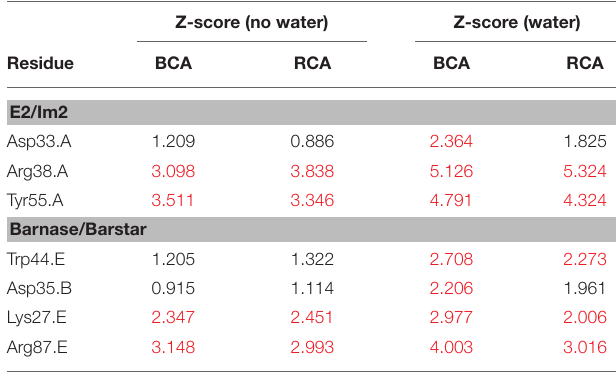
TABLE 2 | List of central residues found in the literature and discussed in the text for the E2/Im2 and the barnase/barstar complexes. Z-score (no